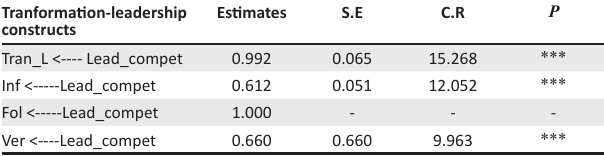
TABLE 9: Structural model parameter estimates and p -values for transformational and leadership effectiveness.